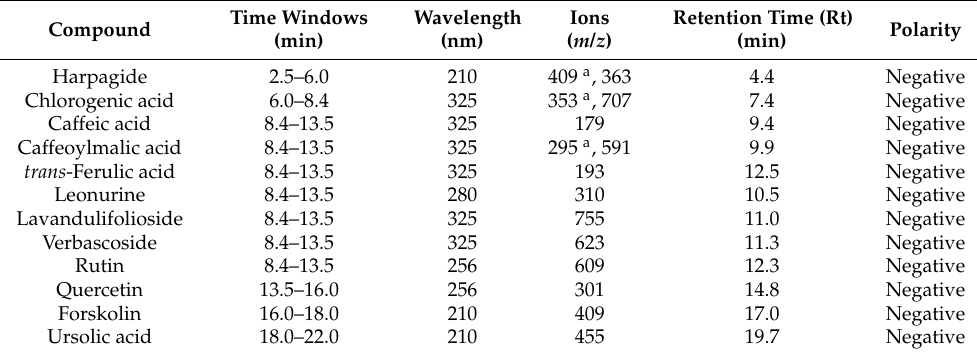
HPLC-DAD-MS parameters for the quantification of 12 bioactive compounds in L. cardiaca